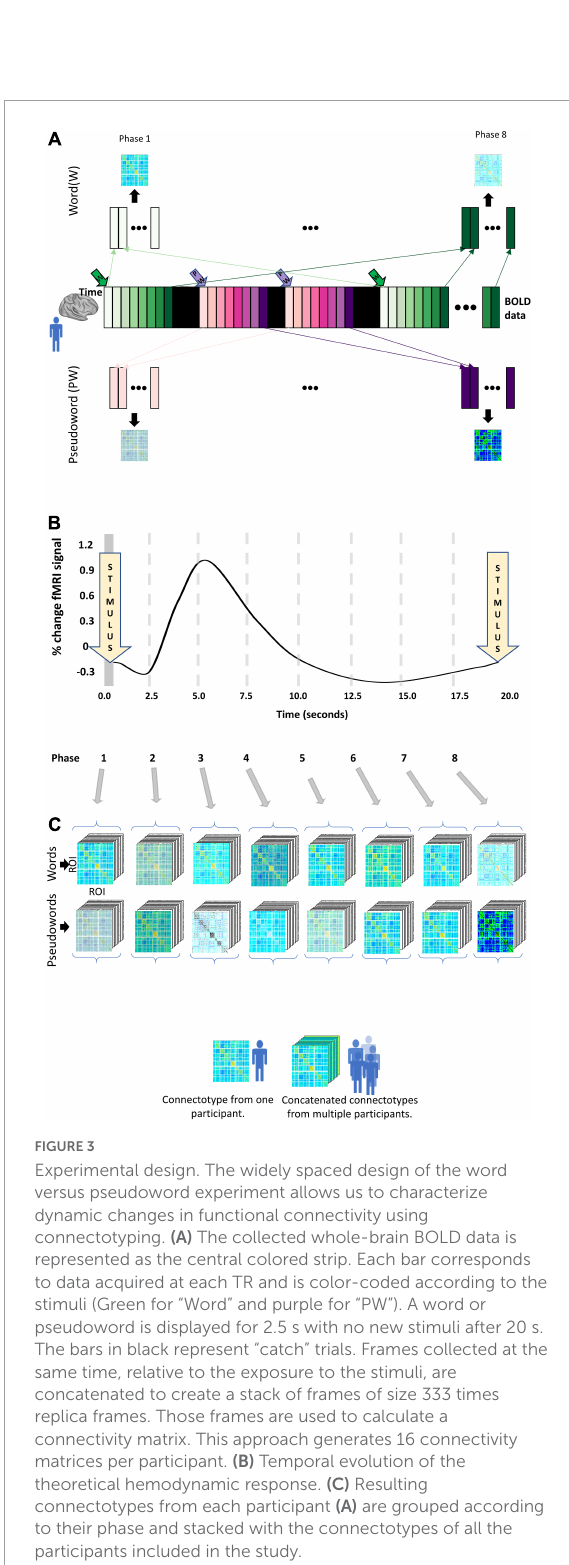
the signal for each region in the system is represented by an equation (see a schematic representation of connectotyping in Figure 1